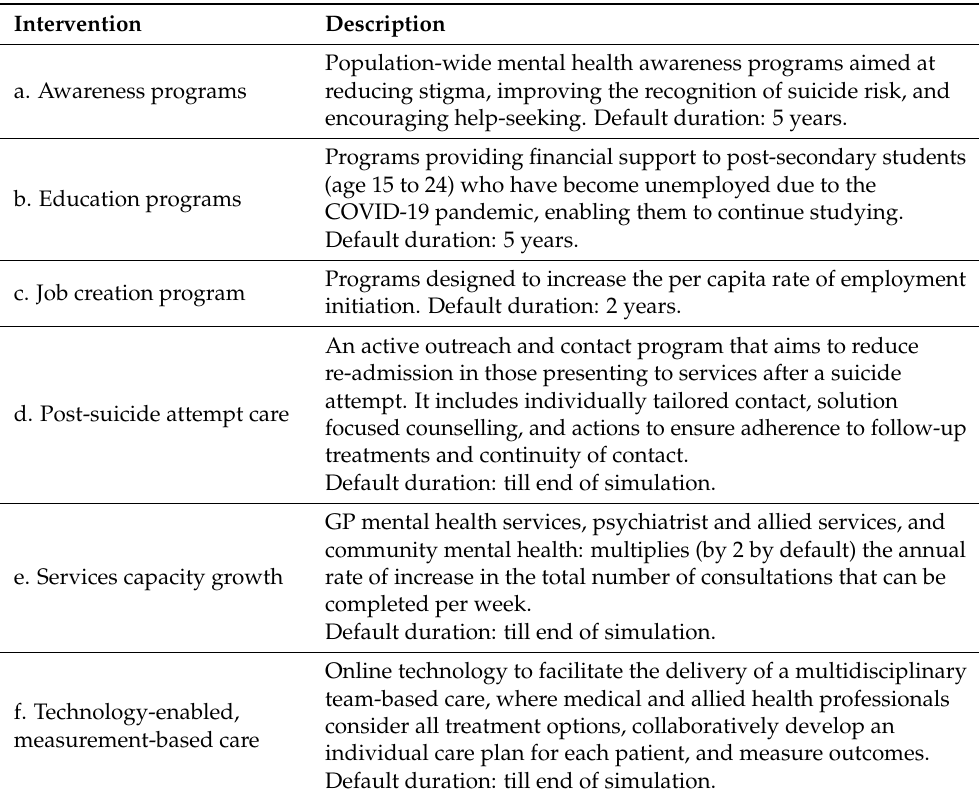
Table 1. Interventions examined in the simulations (further details are provided in Supplementary Table S1). All interventions by default start in January